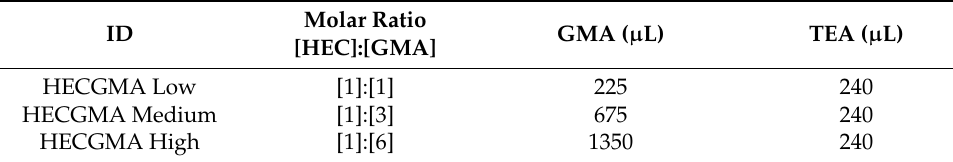
Table 1. Details on HECGMA